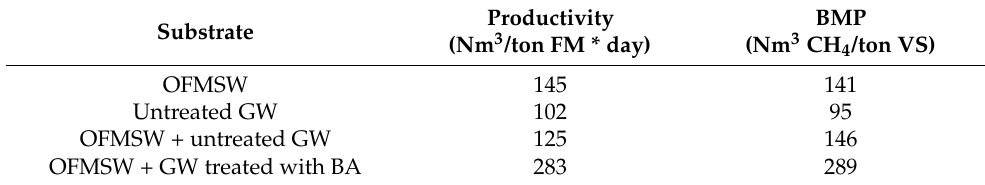
Table 4. Parameters of the AD and anaerobic co-digestion processes considered in this study (OFMSW = organic fraction of municipal solid waste; GW = green waste; BA = Bjerkandera adusta ; FM = fresh matter; BMP = biochemical methane potential; VS = volatile